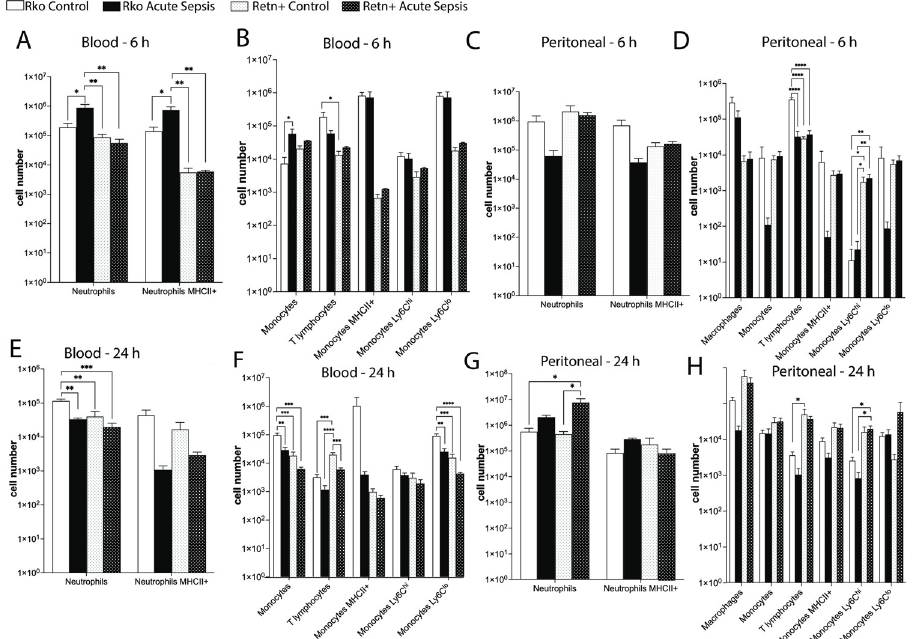
Fig 3. Flow cytometry assessment of cellular differential at 6 h and 24 h post-cecal ligation and puncture, in knockout C57BL/6 mice (Rko) and mice expressing human resistin (Retn+). A, Blood neutrophils at 6 h; B, Blood monocytes and T lymphocytes at 6 h; C, Peritoneal neutrophils at 6 h; D, Peritoneal monocytes, macrophages and T lymphocytes at 6 h; E, Blood neutrophils at 24 h; F, Blood monocytes and T lymphocytes at 24 h; G, Peritoneal neutrophils at 24 h; H, Peritoneal monocytes, macrophages and T lymphocytes at 24 h. n = 4 for Rko at 6 h and 24 h, and for Retn+ at 24 h. n = 3 for Retn+ at 6 h.